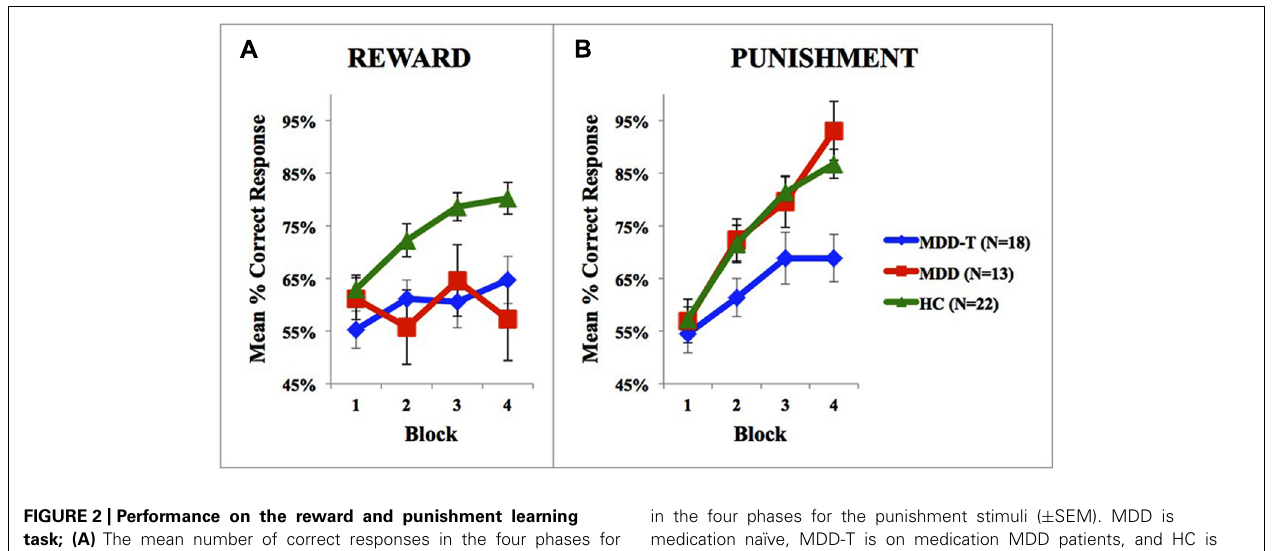
in the four phases for the punishment stimuli ( ± SEM). MDD is medication naïve, MDD-T is on medication MDD patients, and HC is healthy controls.